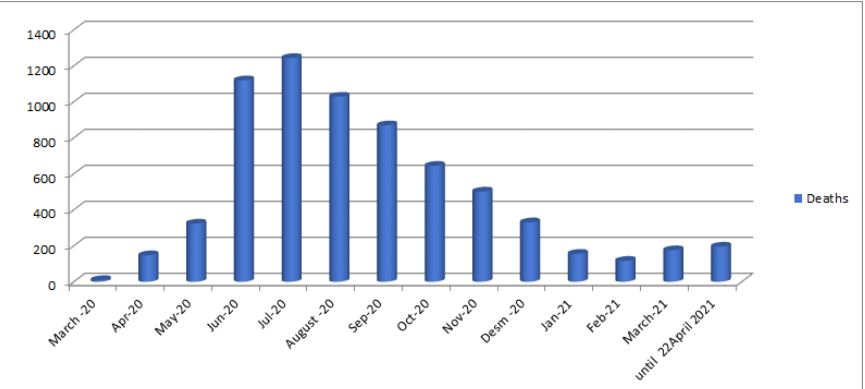
Figure 4. The total number of deaths of COVID-19 in Saudi Arabia for the period from March 2020 to 22 April 2021.